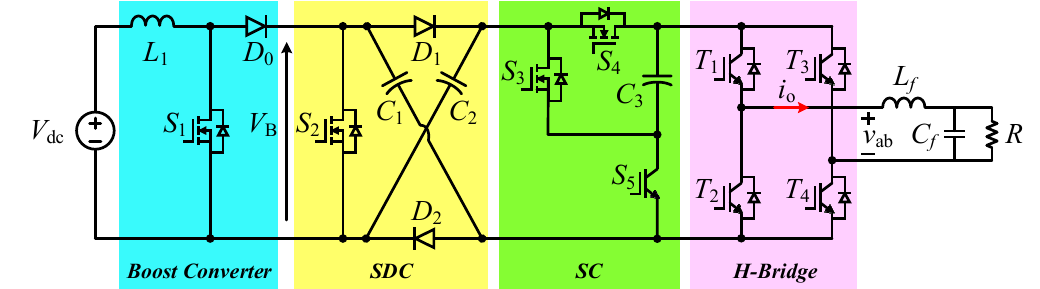
Figure 1. Proposed single-phase nine-level boost inverter (NLBI) topology.